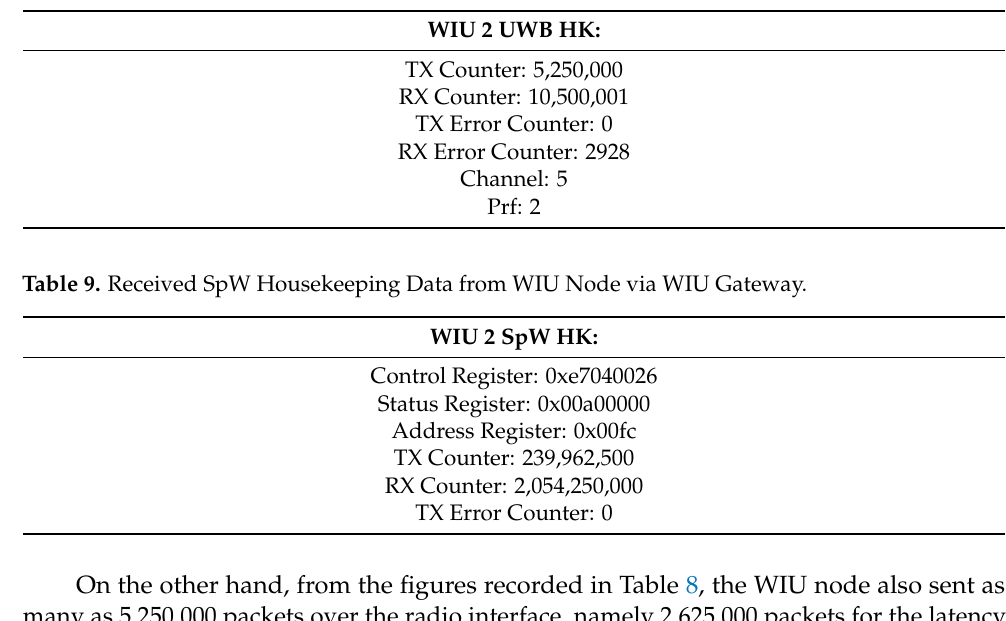
Table 8. Received UWB Housekeeping Data from WIU Node via WIU Gateway.